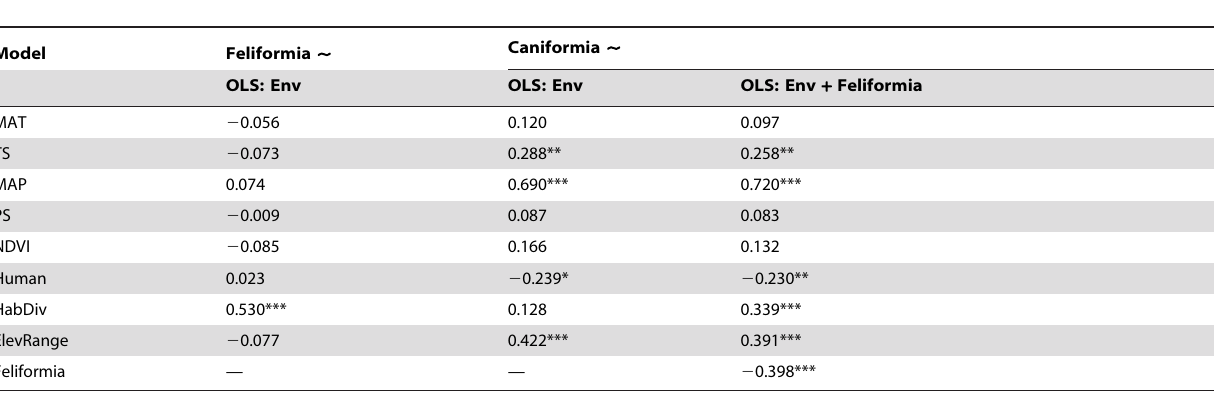
Table 2. Results of the Ordinary-least-squares (OLS) multiple linear regression models of feliform and caniform species richness against environmental (ENV) predictors or these plus species richness of the competing group (Env + Feliformia).